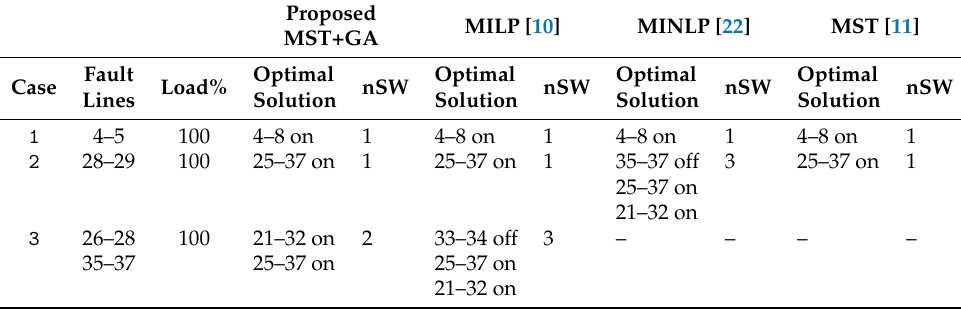
Table 3. IEEE 37 modified test feeder—full restoration strategy comparison of the proposed algorithm with previous